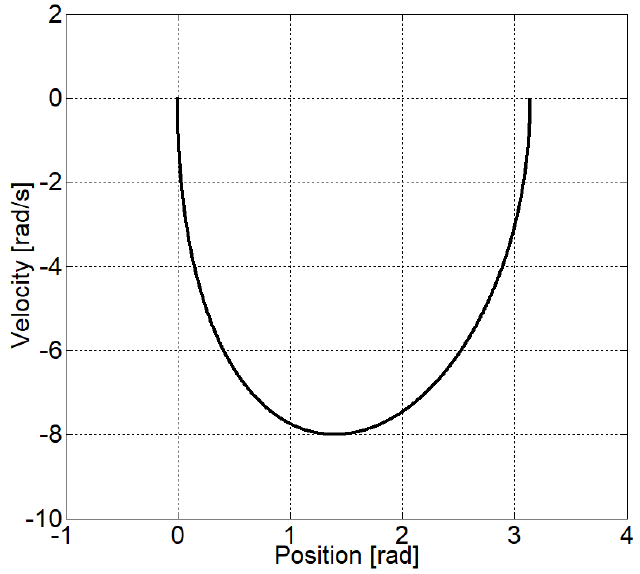
Figure 9. State trajectory with the velocity constraint.